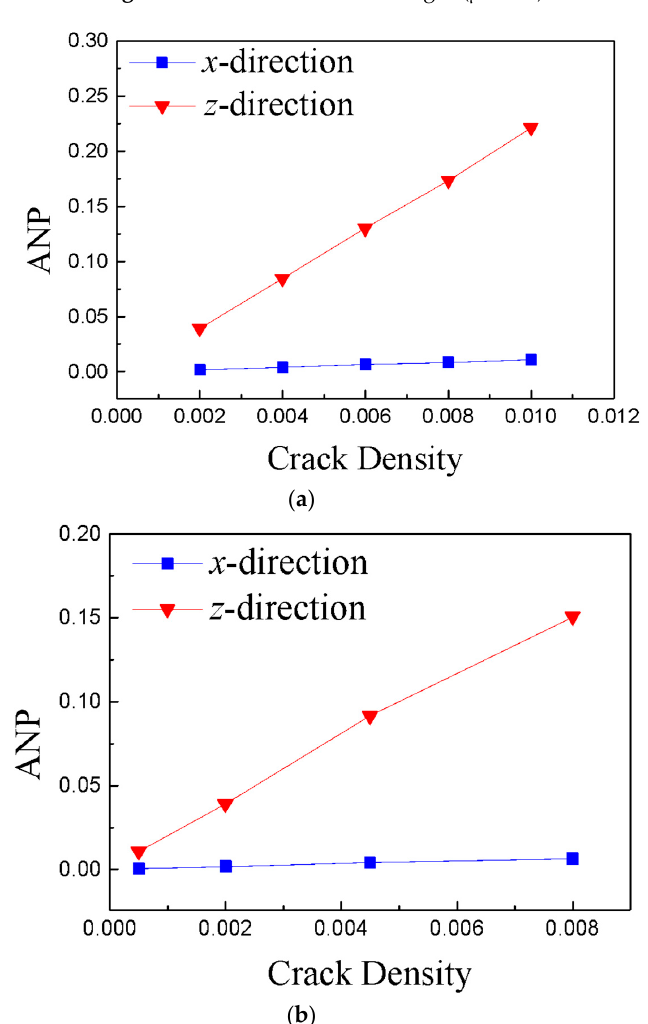
Figure 14. ANP versus crack length ( μ = 0.3). Appl. Sci. 2020 , 10 , 741